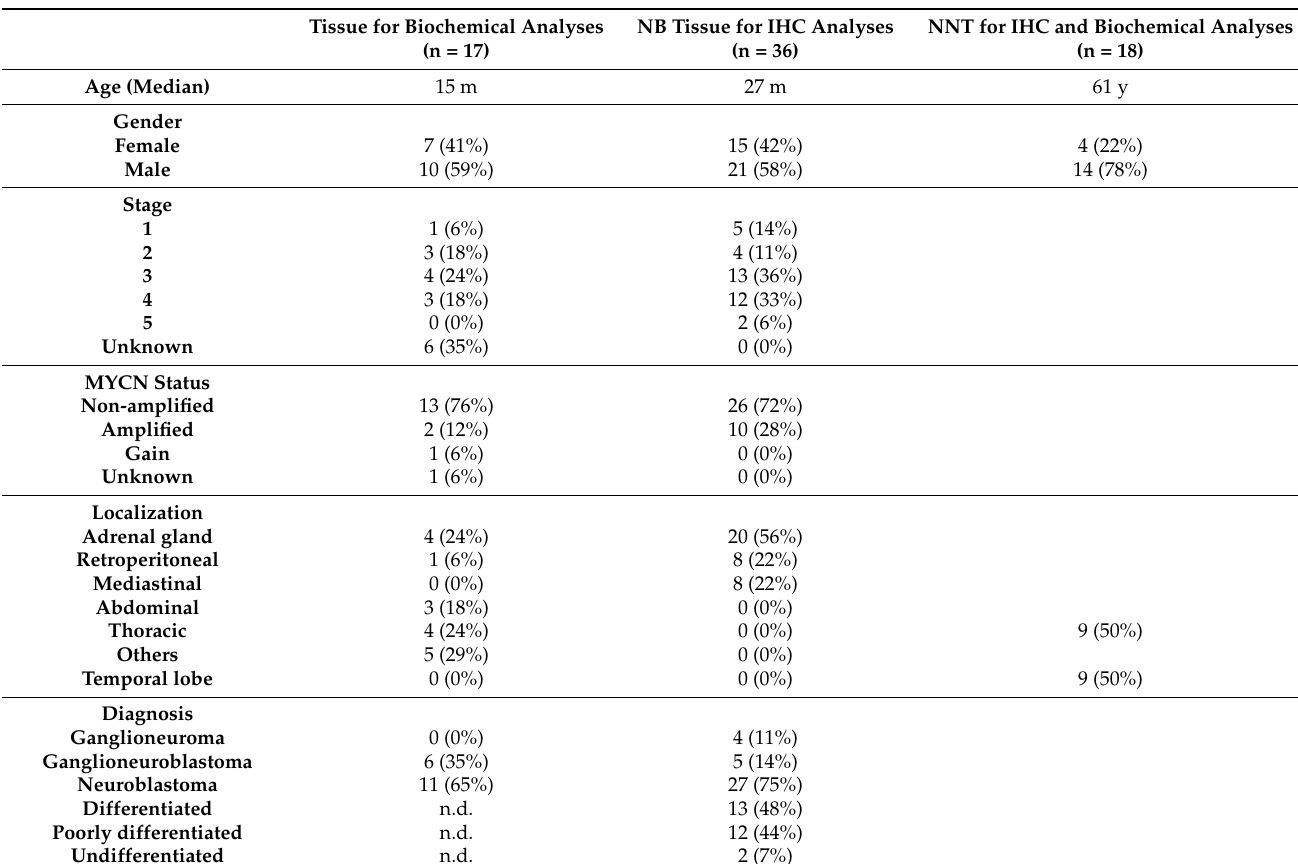
Table 1. Clinicopathological data of patient-derived neuroblastoma tissue and warm autopsy-derived non-neoplastic tissue. Tissue for Biochemical Analyses NB Tissue for IHC Analyses NNT for IHC and Biochemical Analyses (n = 17) (n = 36) (n = 18) 61